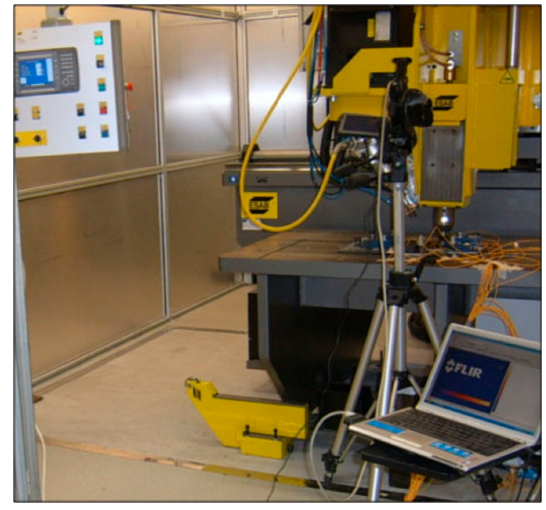
Figure 3. ESAB welding station used for FSW tests.